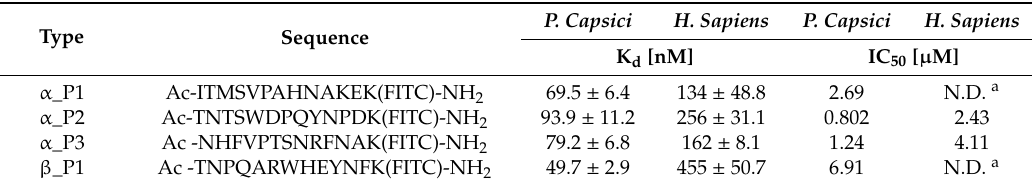
Table 2. Binding affinity and inhibitory potency of the modified peptides against P. capsici and H. sapiens α , β -tubulin.